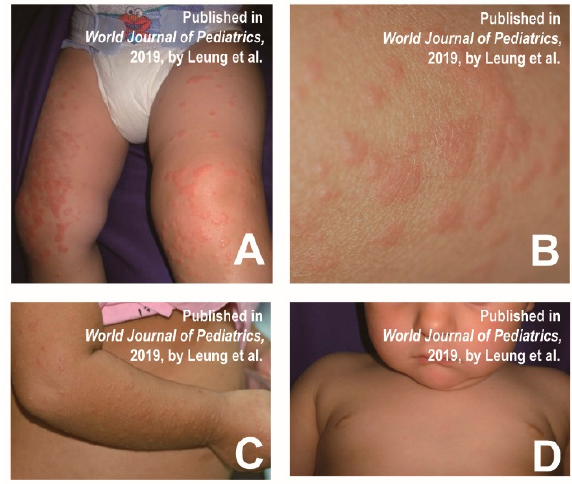
Figure 1. ( A ) Multiple individual, flat-topped, erythematous papules on the external surface of the lower limbs. ( B ) Well-defined and non-squamous papules on the right thigh. ( C ) Multiple monomorphic, flat-topped, erythematous papules on the external surface of the upper limb. ( D ) Monomorphic erythematous papules on the face, with sparing of the trunk. Reprinted/adapted with permission from Ref. [13] . 2019, Leung et al.